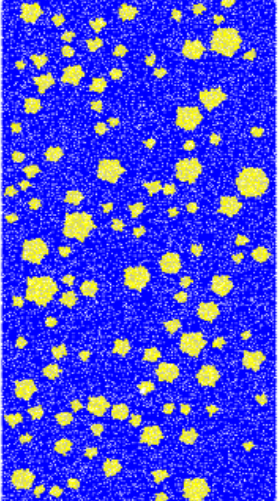
Figure 2. Discrete particle element model.